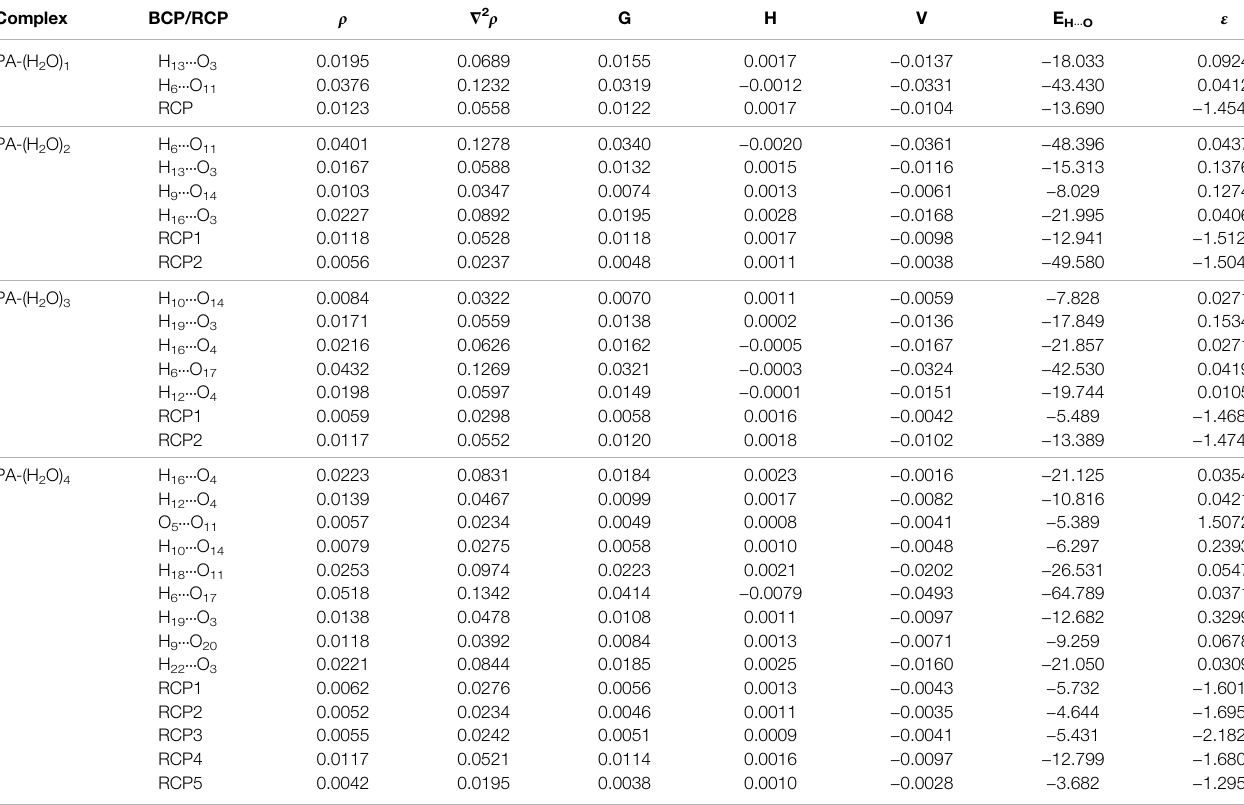
TABLE 3 | Topological parameters obtained from AIM analysis for the considered molecular associations in the urea – water mixture ( ρ : electron density (a.u.); ∇ 2 ρ : Laplacian of electron density (a.u.); G: Lagrangian kinetic energy (a.u.); H: Hamiltonian kinetic energy (a.u.); V: potential energy density (a.u.); E H ··· O : H-bond energy (kJ/mol)), ε : ellipticity of electron density. BCP: bond critical point; RCP: ring critical